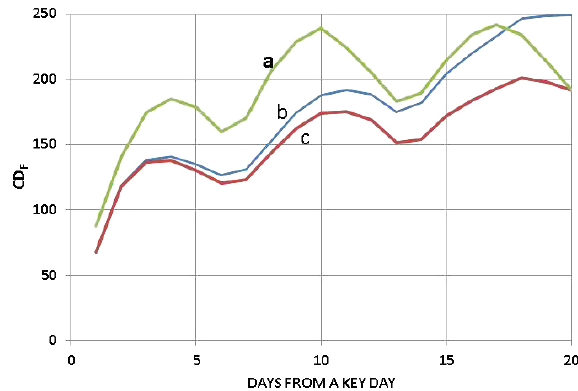
Figure 5. Mean CD F for (a) 10% of southeastern sites and (c) 18% of southwestern sites showing regular oscillations with time after a key day. (c) is (b) corrected for the artifact described in Sect. 3.